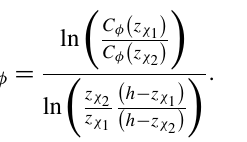
(cid:49)C φ ( z χ = 05 h ) = ± 10%. (c) Relative C φ